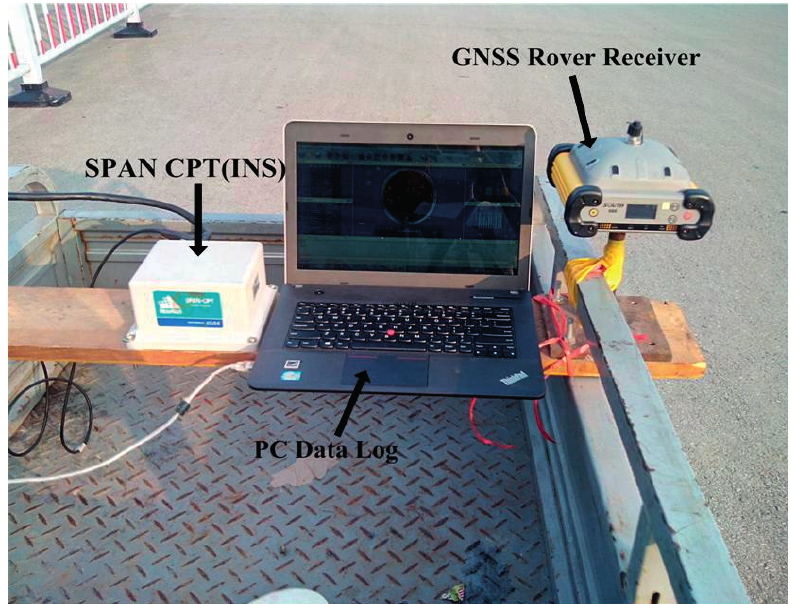
Figure 3. Testing